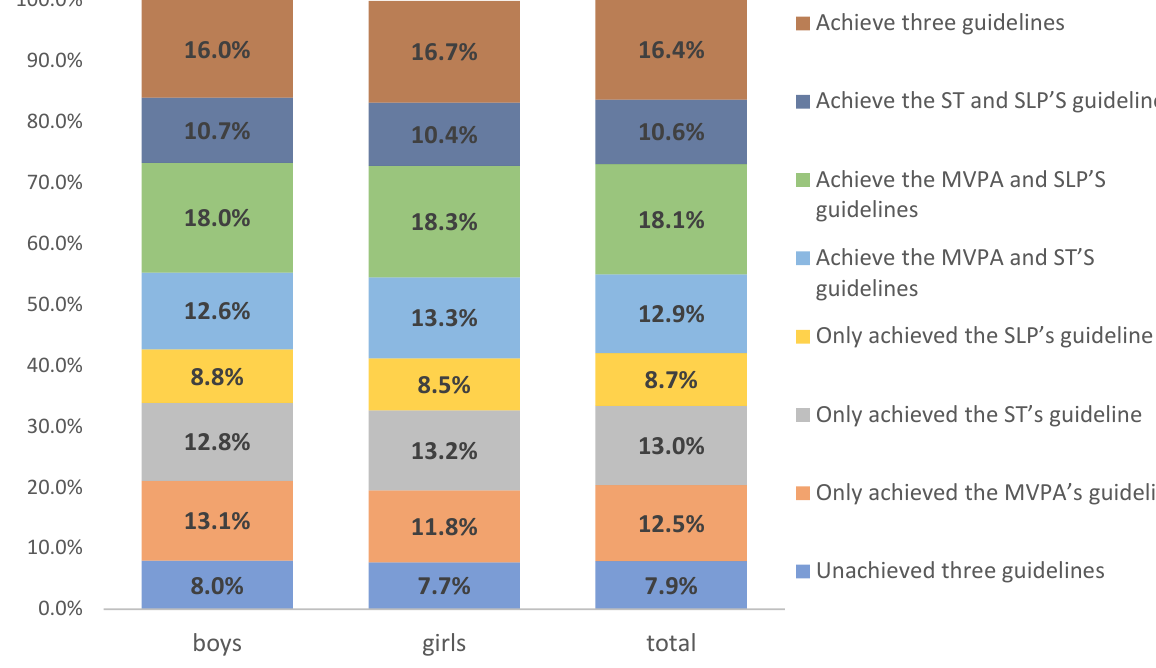
Figure 3. The proportions of the eight groups in the respondents.